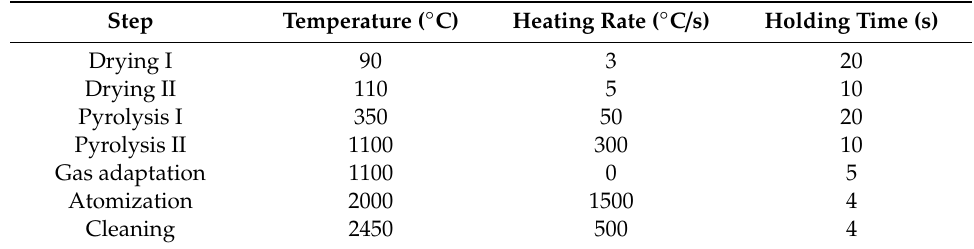
Table 1. Parameters for graphite furnace program for direct detection of copper oxide nanoparticles (CuONPs) in active extract samples by means of high-resolution continuum source graphite furnace atomic absorption spectrometry (HRCS SS